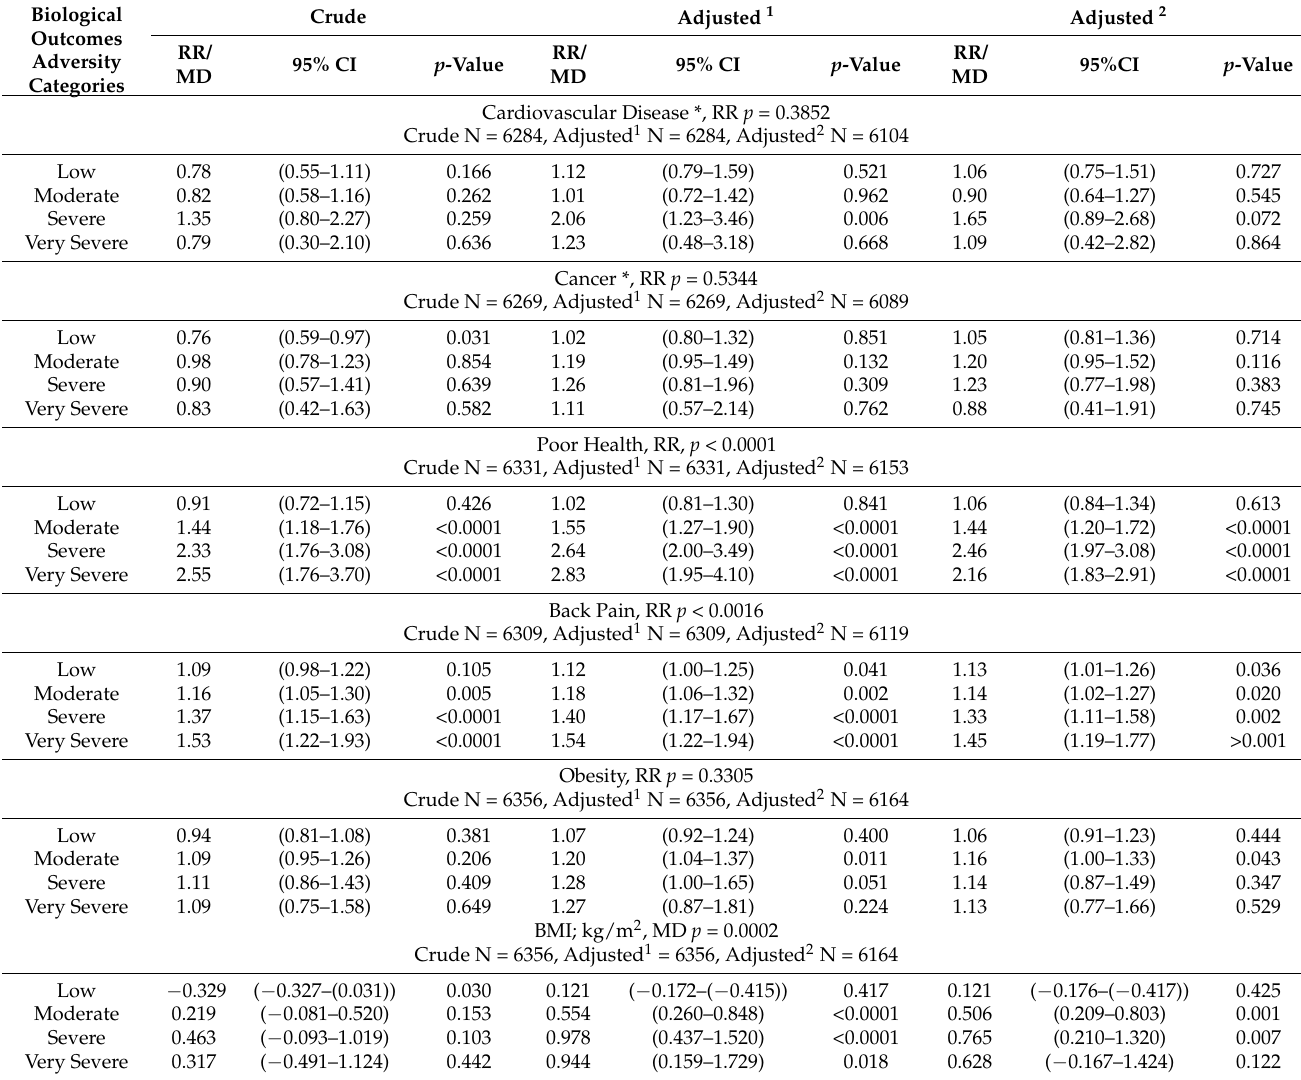
Table 5. Risk Ratio and Mean Differences between WICAC and biological